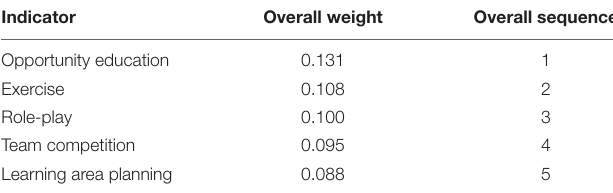
Overall weight Hierarchy